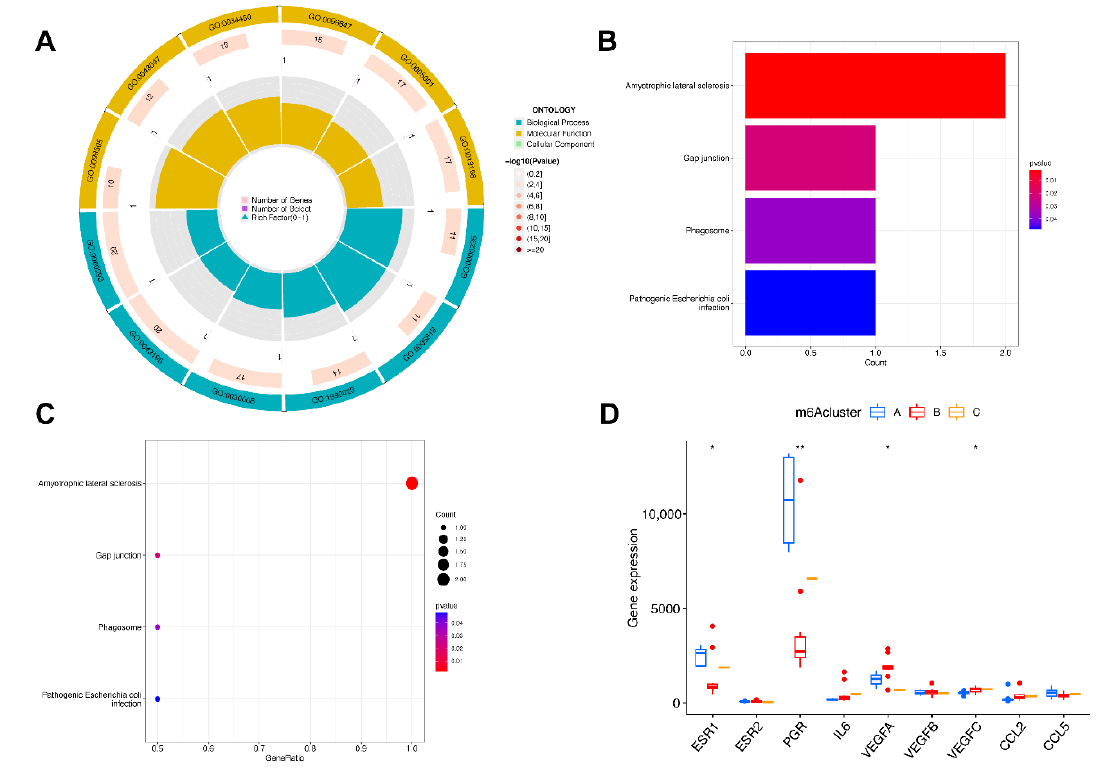
Figure 7. Pathway and functional enrichment of DEGs and the expression level of endometriosis biomarkers in three clusters. ( A ) GO functional enrichment. ( B , C ) The KEGG pathway enrichment. ( D ) The differential expression of endometriosis biomarkers in three subtypes. * p < 0.05 and ** p <